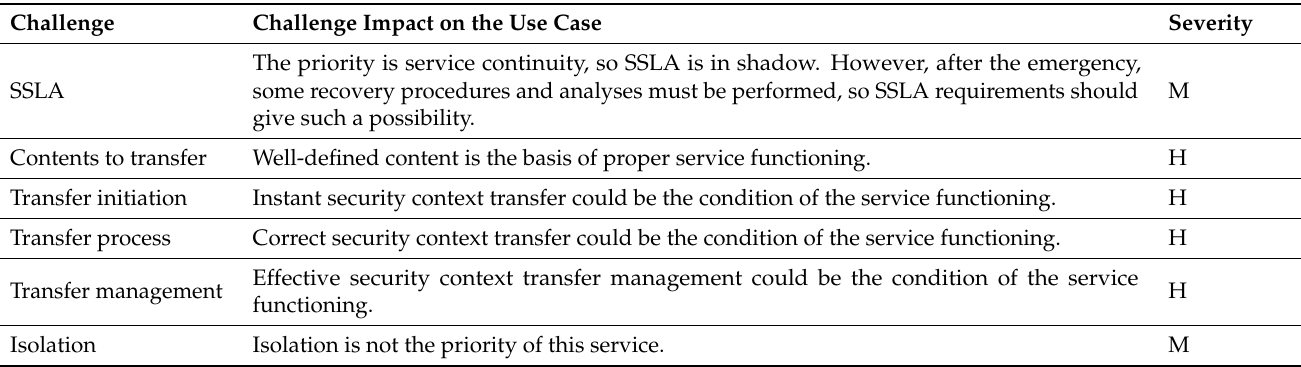
Table 10. Challenges in the critical communication (emergency) use case.